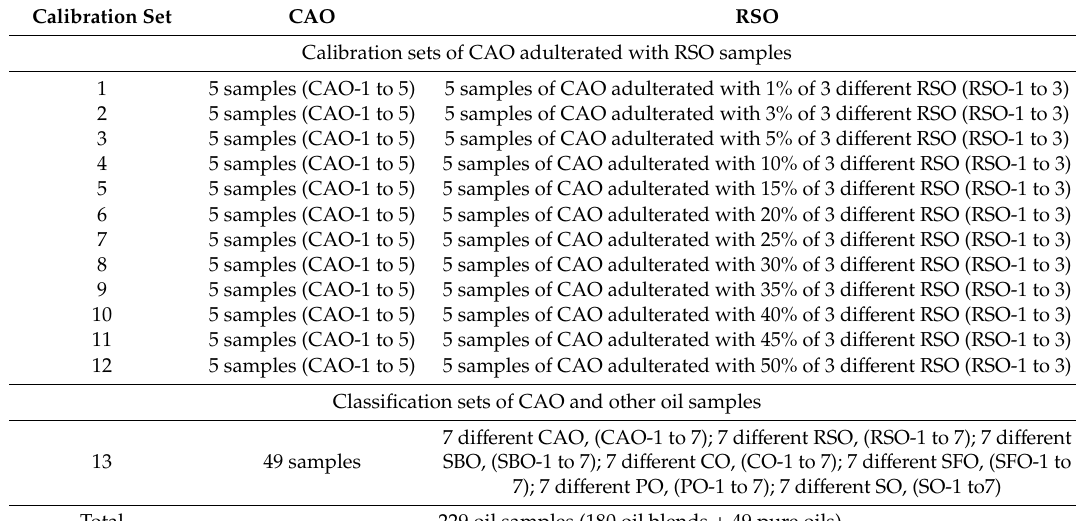
Table 5. Major oil sample preparation procedure for